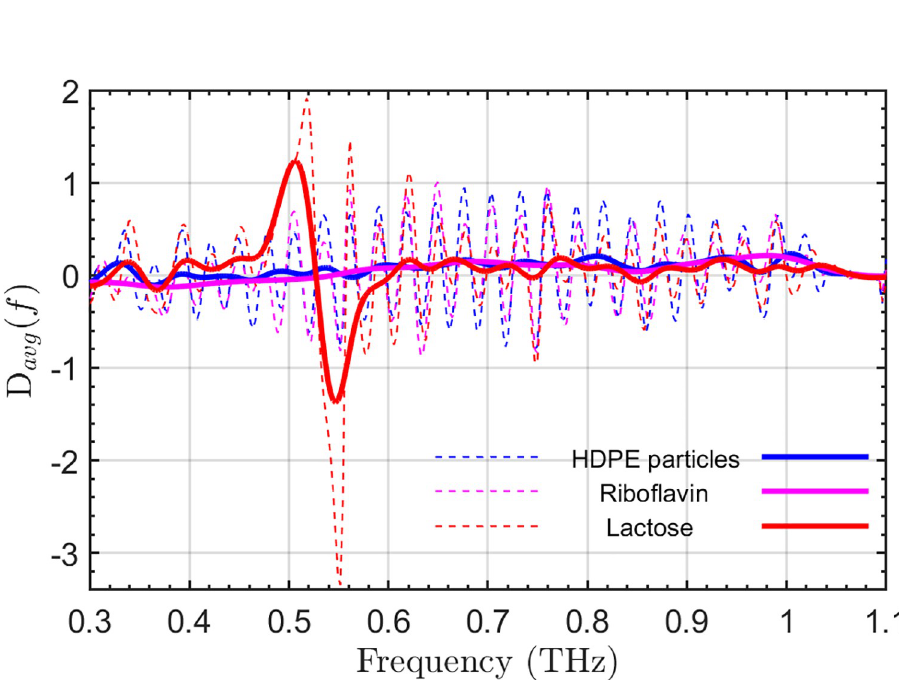
Fig 5. Before and after cepstrum filtering. D avg ( f , θ 0- ± 5 ) of a single pixel propagating through only HDPE particles (blue), the lactose pellet and scattering particles (red), and the riboflavin pellet and scattering particles (magenta). The D avg ( f , θ 0- ± 5 ) is shown before (dashed) and after (solid) cepstrum